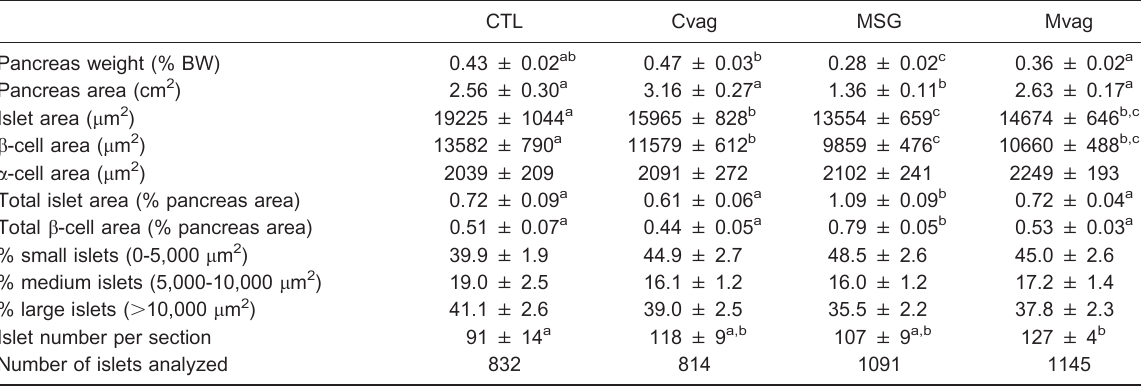
Table 3. Morphometric analysis of the pancreas of 90-day-old CTL, Cvag, MSG and Mvag